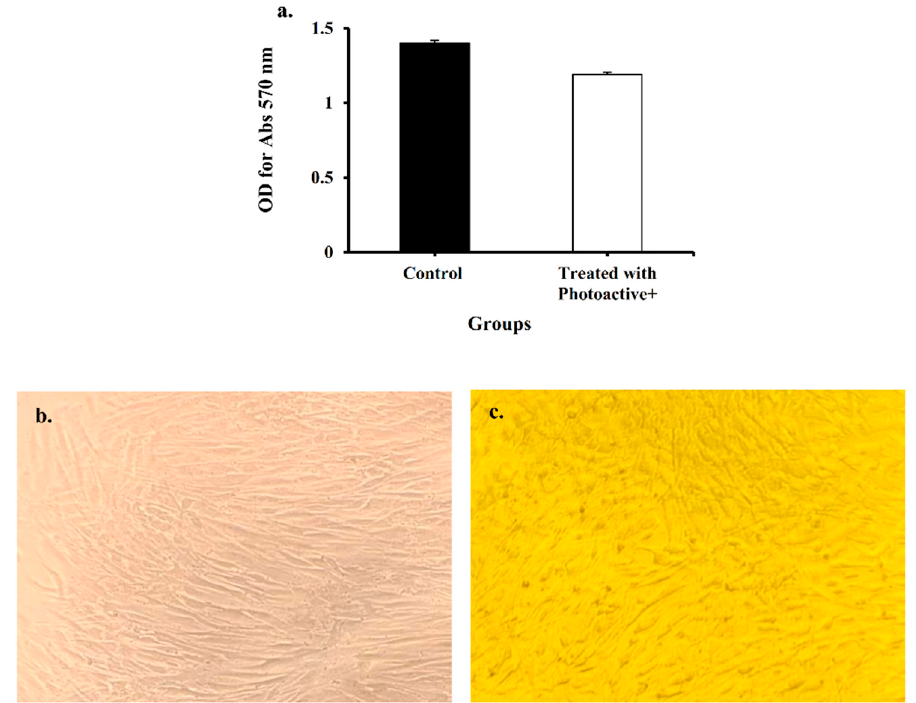
Figure 3. Cell cytotoxicity assessment. ( a ) MTT assay control group (1.4), Photoactive+ (1.19); Photomicrographs of HuGu cells under light inverted microscopy: ( b ) control group; ( c ) cells exposed to Photoactive+ at concentration of 0.01 g/mL.